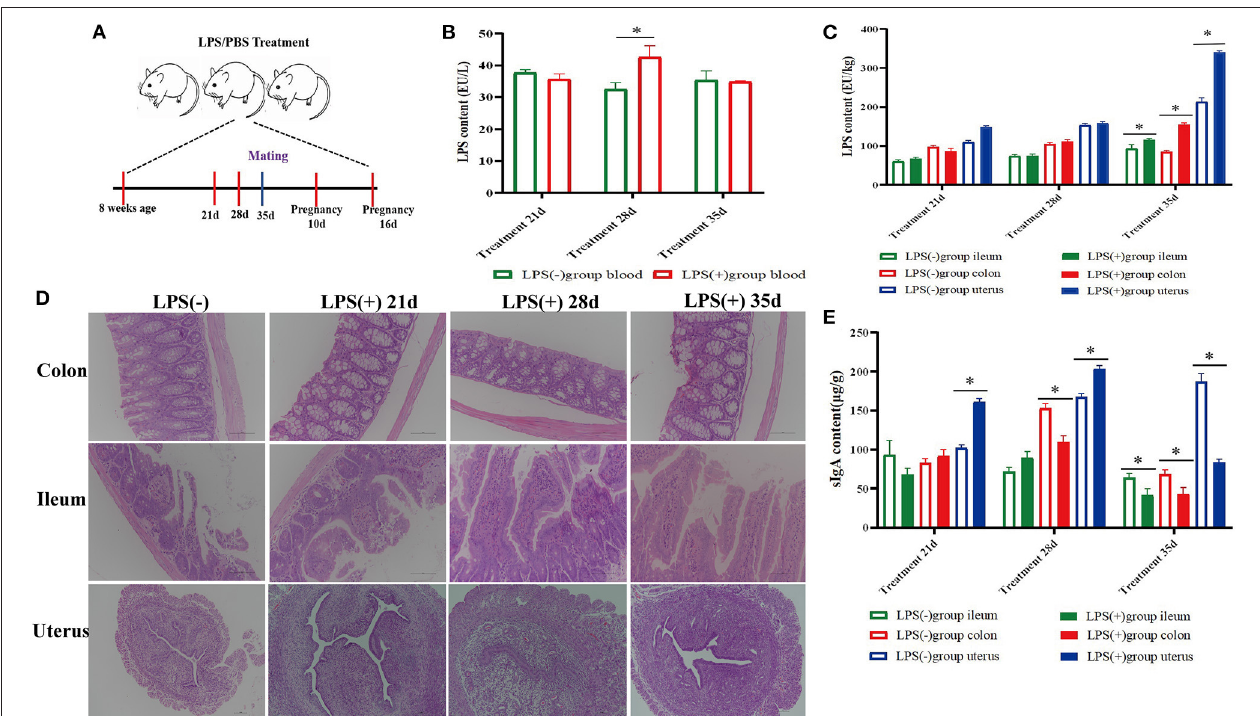
FIGURE 1 | Effect of mouse LPS treatment for 35 days on histomorphology and biochemical indices of ileum, colon, and uterus tissues. (A) Experimental design; (B) LPS content in the blood of mice treated with LPS for 21 days ( n = 10), 28 days ( n = 10), and 35 days ( n = 10). (C) LPS content in the colon, ileum, and uterine tissue of mice treated with LPS for 21 days ( n = 10), 28 days ( n = 10), and 35 days ( n = 10). (D) Histomorphological changes in the colon, ileum, and uterine tissue of mice treated with LPS for 21 days ( n = 10), 28 days ( n = 10), and 35 days ( n = 10). (E) SIgA content in the colon, ileum, and uterus of mice treated with LPS for 21 days ( n = 10), 28 days ( n = 10), and 35 days ( n = 10). * p < 0.05 indicates a significant difference between the LPS( + ) group and the LPS( − ) group during the same